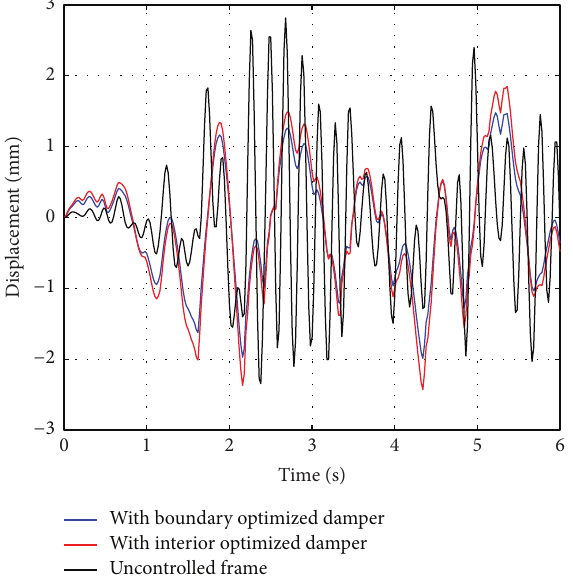
Figure 32: Time-history curve under medium earthquake.